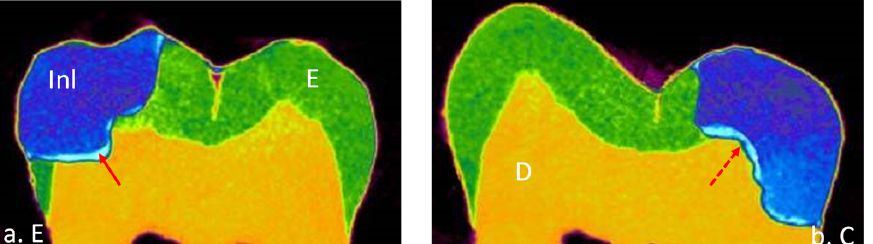
Figure 3. Micro-CT images of internal and marginal gap at the gingival floor of a Class II Lava Ulti- mate inlay luted with e Cement resin cement on ( a ) enamel and ( b ) cementum/dentin. Adhesive layer contains: solid arrow, silver deposits; dotted arrow, void.